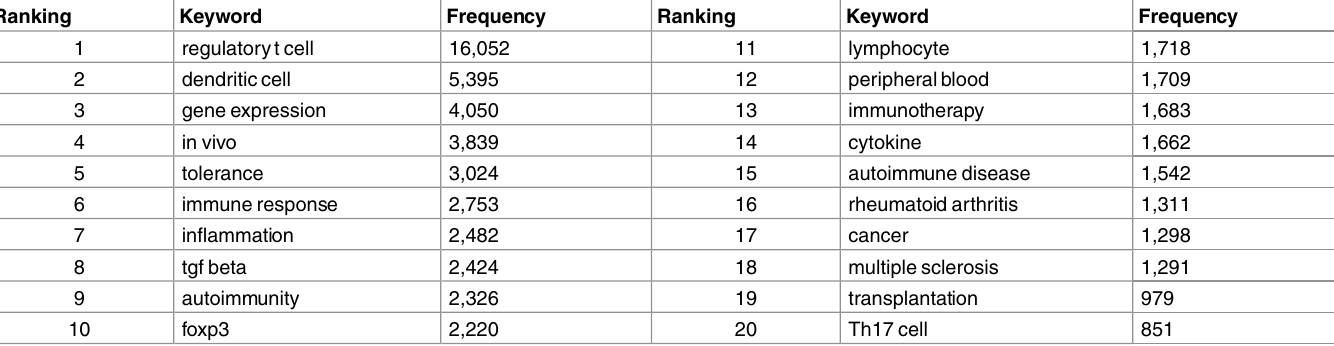
Table 5. The 20 most frequently used keywords in articlesrelatedto regulatoryT cell (Treg) research published from 2000 to